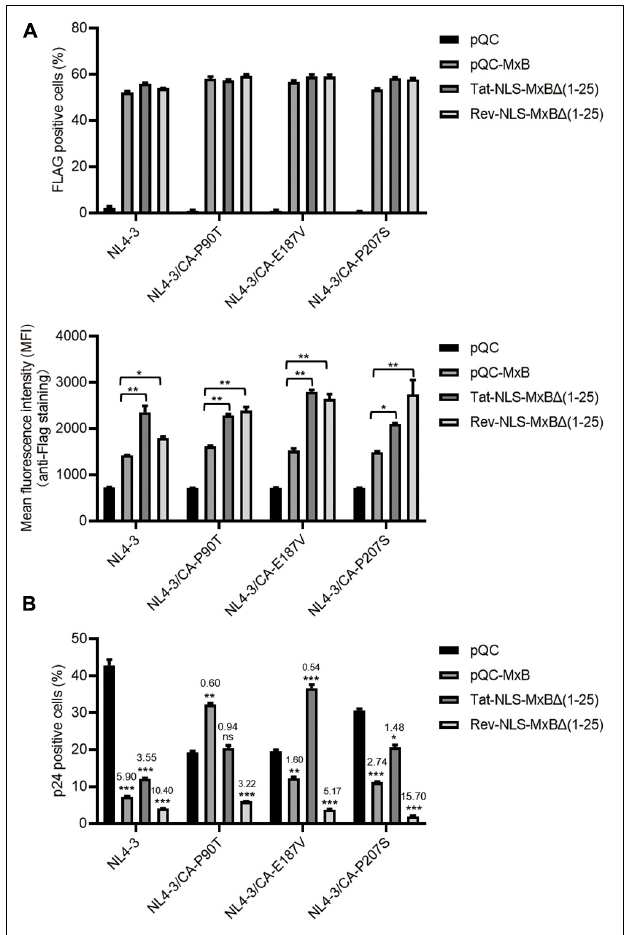
FIGURE 6 | MxB and its mutants bearing the arginine-rich NLS differentially inhibit wild type HIV-1 and viral mutants having CA mutations. SupT1 cells were transduced with retroviral particles that express MxB, Tat-NLS-MxB (cid:49) (1–25), or Rev-NLS-MxB (cid:49) (1–25), followed by infection with HIV-1 and its mutants CA-P90T, CA-E187V, or CA-P207S. MxB and its mutants contain a FLAG tag at the C-terminus. (A) Expression of MxB and its mutants was detected by anti-FLAG immunostaining. The percentages of FLAG-positive cells were scored by flow cytometry, and mean fluorescence intensity (MFI) values of FLAG staining were calculated and presented in the bar graphs. Results shown are the average of three independent experiments. * p < 0.05, ** p < 0.001, *** p < 0.0001, ns, not significant. (B) HIV-1 infected cells were detected by immunostaining viral p24. The percentages of viral p24 positive cells in the Flag-positive cell population were scored by flow cytometry. Results shown are the average of three independent experiments. Fold of inhibition of HIV-1 infection by MxB or its mutants were calculated with reference to the infection of control cells by wild type HIV-1 or viral mutants. * p < 0.05, ** p < 0.001, *** p < 0.0001. ns, not